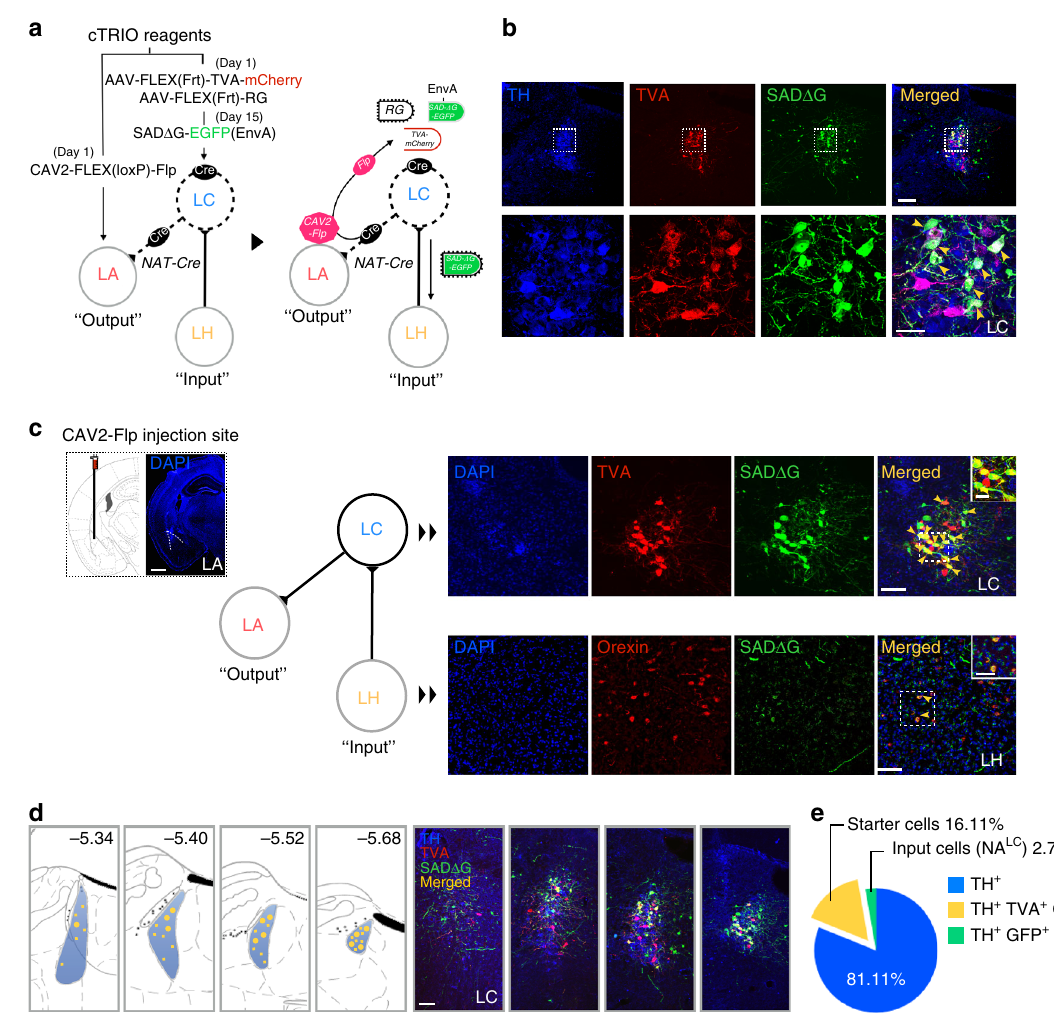
Fig. 3 Trans-synaptic tracing of orexin LH → LC to NA LC → LA circuit by cTRIO. a Experimental procedure. We injected CAV2-FLEX (loxP)-Flp into the LA of NAT-Cre mice to express Flp in LC NA neurons that send projections to the LA (Day 1). Flp-dependent AAV carrying TVA , RG were then injected into the LC (Day 1). SAD Δ G-EGFP (EnvA) was injected into the same site (Day 15). b Upper panels show that the starter cells (TVA + , SAD Δ G + cells) in the LC are NA neurons. From left to right, TH + , TVA + , SAD Δ G-EGFP + , and merged cells (shown by yellow arrow heads) are shown. Lower panels, higher power images of corresponding upper panels of the rectangular regions. Scale bars, 200 μ m (upper), 50 μ m (lower). c Left panels, injection site of CAV2-FLEX (loxP)-Flp in the LA. Scale bar, 600 μ m. Right upper panels, NA LC neurons expressing TVA and SAD Δ G-EGFP (yellow arrow heads). Scale bars: Large window, 100 μ m; small window, 30 μ m. Lower panels, orexin LH neurons expressing SAD Δ G-EGFP (yellow arrow heads), suggesting that NA LC → LA neurons receive monosynaptic input from orexin neurons. Scale bars: large window, 100 μ m; small window, 50 μ m. d Left four panels, distribution of starter cells (merged) in the LC region. Each small yellow dot shows one merged cell, large dot includes two merged cells. Right four panels show a representative image of starter cells in different locations of the LC. Scale bar: 100 μ m. e Graph shows the percentage of TH + (blue), TH + /TVA + /SAD Δ G + (yellow), TH + /SAD Δ G + (green) cells in the